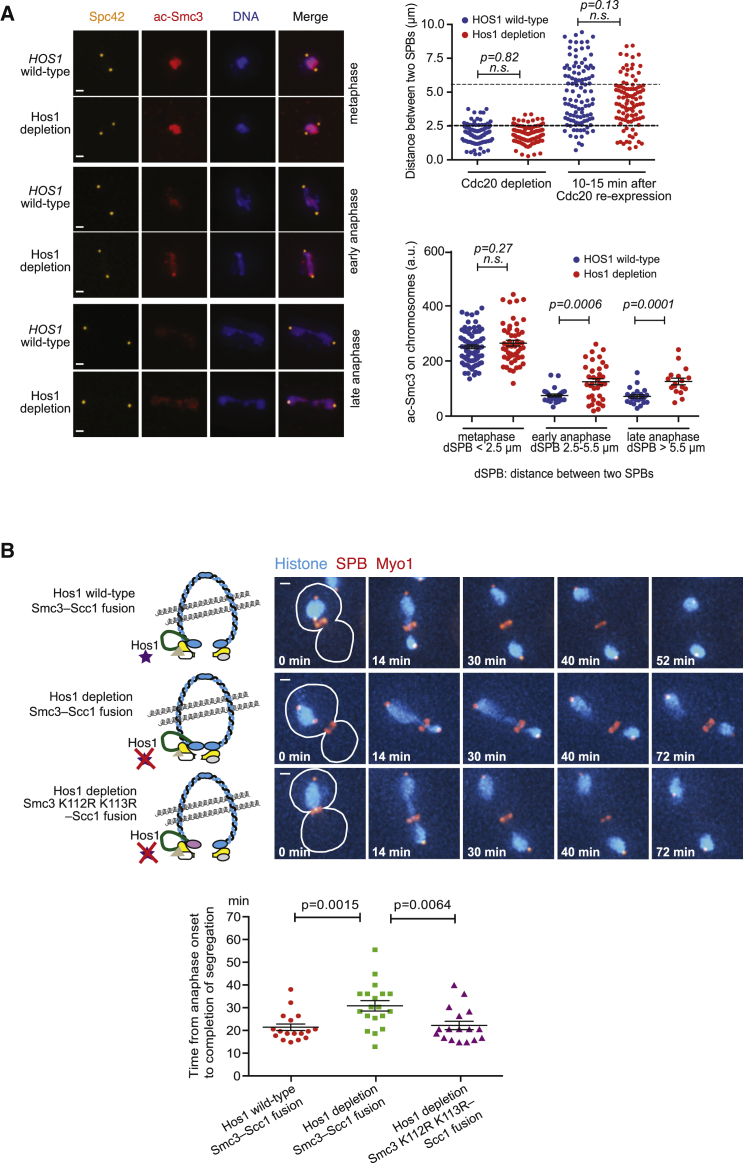
Smc3 Deacetylation at K112 and K113 by Hos1 Leads to Efficient Cohesin Removal in Anaphase and Timely Chromosome Segregation(A) A larger amount of acetyl-Smc3 remains on anaphase chromosomes in Hos1-depleted cells. HOS1 wild-type (T13179) and hos1-aid (T13180) cells with PGAL-CDC20 Spc42-mCherry were arrested in metaphase and subsequently released to anaphase, as in Figure 2C. NAA was added to deplete Hos1-aid, as in Figure 2C. Cells in metaphase arrest and in anaphase (10–15 min after CDC20 re-expression) were taken, and chromosomes were fixed and immobilized on a slide glass immediately after cell lysis. Representative cells are shown on the left. The distance between two SPBs (right, top) and acetyl-Smc3 (ac-Smc3) signals on chromosomes (right, bottom) were quantified. DNA signals showed elongation, and the distance between two SPBs was enlarged in this assay when cells proceeded from metaphase to anaphase (Renshaw et al., 2010). Cells in metaphase, early anaphase, and late anaphase were defined by SPB-SPB distance (right, bottom). Scale bars, 1 μm; a.u., arbitrary unit; n.s., no significant difference. p value was obtained by t test. Bars and error bars show means and SEMs.(B) Smc3 non-acetyl mutants rescue timely chromosome segregation in Hos1-depleted cells. HOS1 wild-type SMC3-SCC1 fusion (T12684), hos1-aid SMC3-SCC1 fusion (T12665), and hos1-aid SMC3-K112R K113R–SCC1 fusion (T12666) cells with SPC42-mCherry, MYO1-mCherry, and HTB2-CFP were treated, and images were acquired as in Figure 1C. In these cells, the original SMC3 and SCC1 genes were deleted. Representative time-lapse images show chromosomes segregation during anaphase (scale bar, 1 μm). Anaphase onset (0 min) is defined, and time required for completion of chromosome segregation was analyzed (graph) as in Figure 1C. p values were obtained by t test. In the examples shown, chromosome segregation completed at 24, 42, and 24 min (from top to bottom).See also Figure S3.